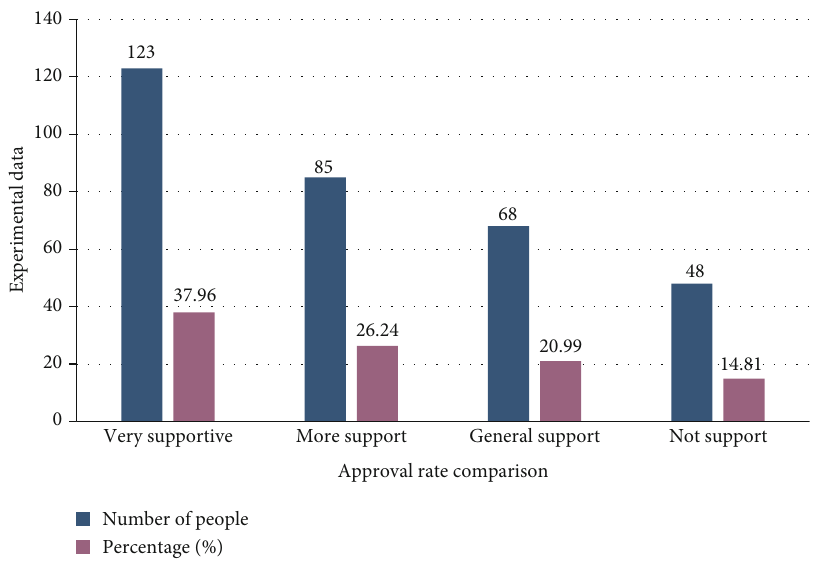
Figure 3: Analysis of support rate of folk-custom sports towns.